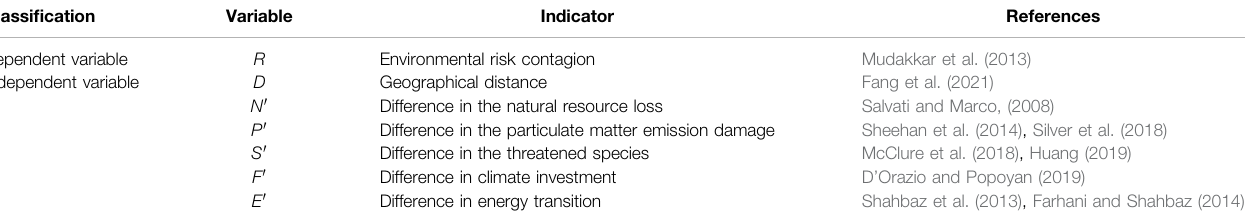
TABLE 1 | Classi fi cation, variable, indicator, and reference.